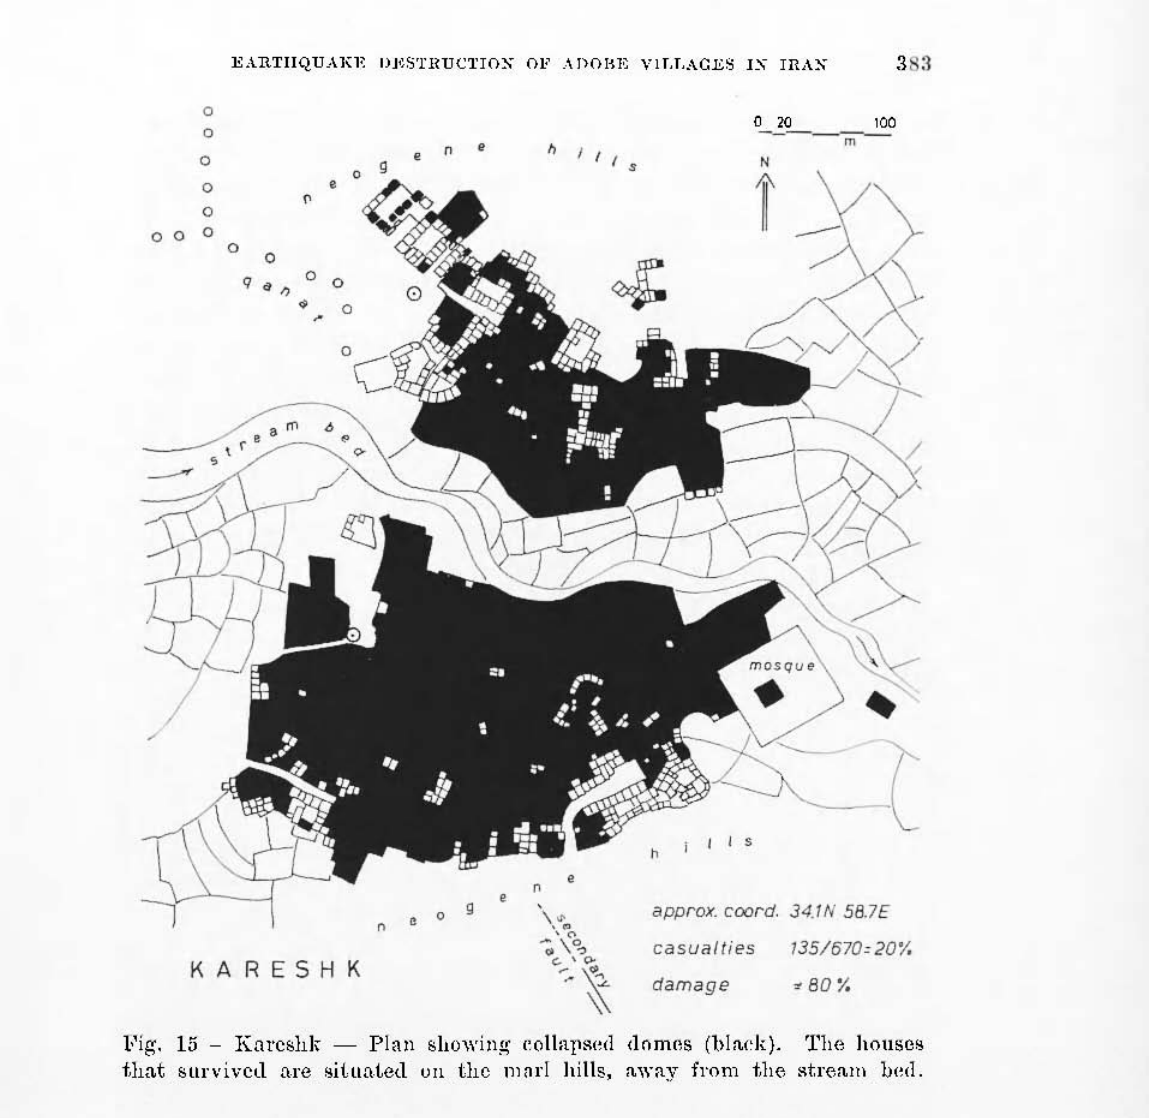
Fig. 15 - Kal'cshk - PIan showing eollal'R(~d (lr.ffills (bln.di:). Thll hOllse8 that sllnivcLl are 8itllateLl un thc mnrI hilIs, n-way from the Rtren-m b(~(l.